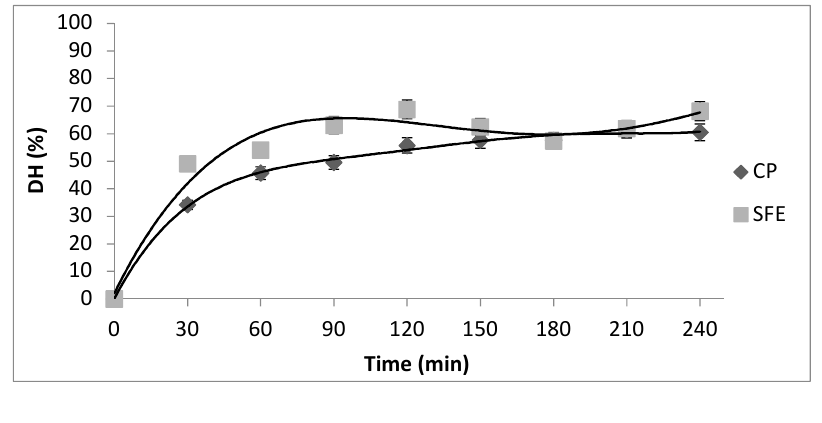
Figure 2. α -glucosidase inhibition potential ( α -GIP) of apricot oil cake protein isolates obtained by cold pressing (CP) and supercritical fluid extraction (SFE) at di ff erent concentrations. Values represent the mean ± standard deviation (SD) of n = 3 replicate analysis.